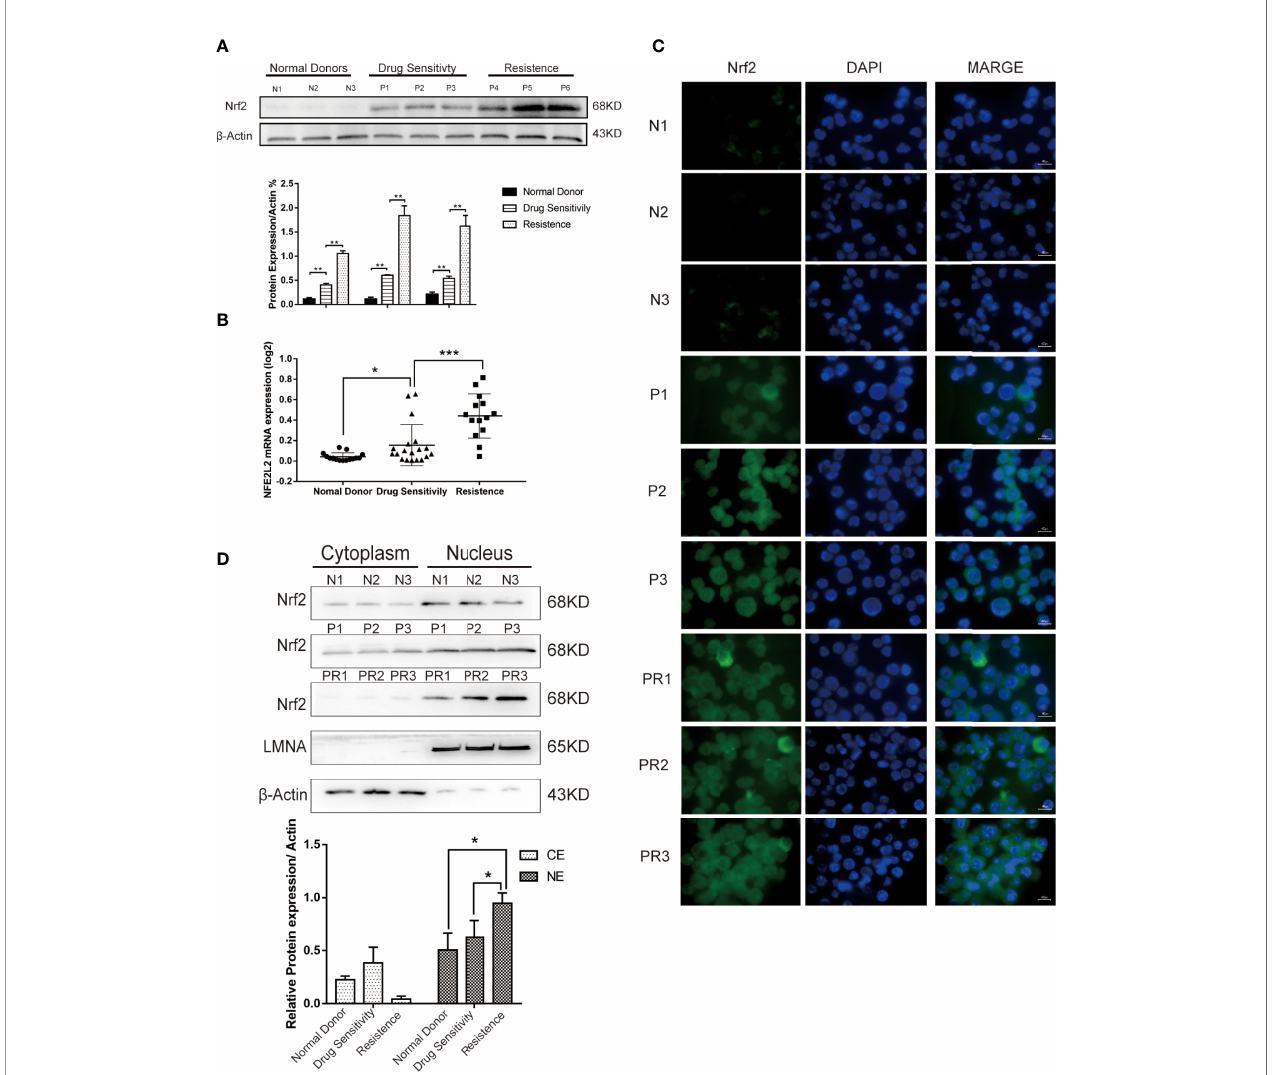
FIGURE 1 | (A) Expression levels of Nrf2 protein were detected in 3 donors and 6 B-ALL samples by western blot. (B) Quanti fi cation of Nrf2 expression in donors (n = 15) and B-ALL samples (Drug sensitivity, n = 19; Resistance, n = 14). Values are presented as mean ± SD (n = 3), *P < 0.05, **P < 0.01, ***P < 0.001. (C) Immuno fl uorescence staining analysis of the expression of Nrf2 in ALL patients (N, normal donors; P, patients of drug sensitivity; PR, patients of resistance). Green indicates Nrf2, and blue indicates DAPI. Scale bars = 10 m m. (D) Cytoplasmic and nuclear fractionation kit was used to obtain the cytosolic and nuclear protein. LMNA and b -Actin were considered as nuclear and cytosolic loading control, respectively (N: normal donors, P: patients of drug sensitivity, PR: patients of resistance). And bands were quanti fi ed. NE, nuclear extract. CE, Cytosolic extract. Values are presented as mean ± SD (n = 3). Signi fi cant differences are indicated by *p < 0.05 vs. Ctrl-NE